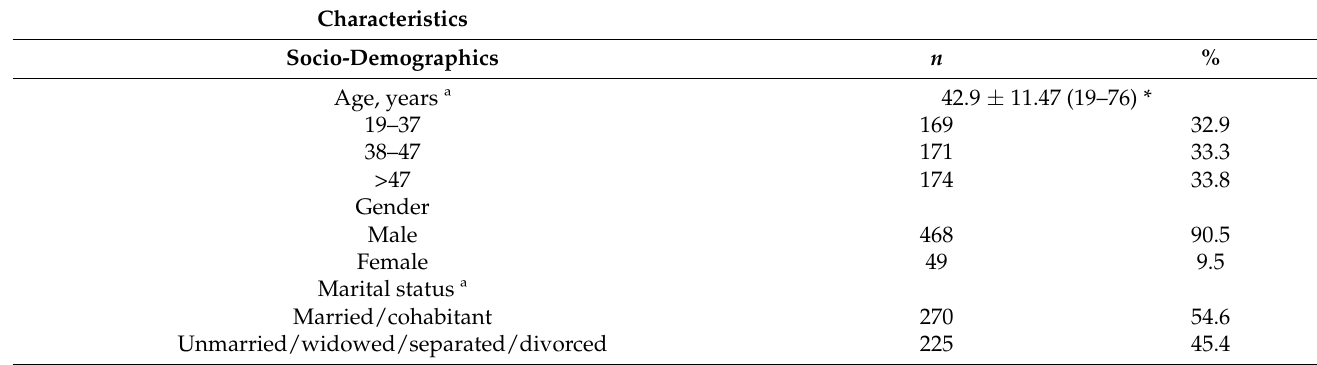
Table 1. Characteristics of the study population ( n =